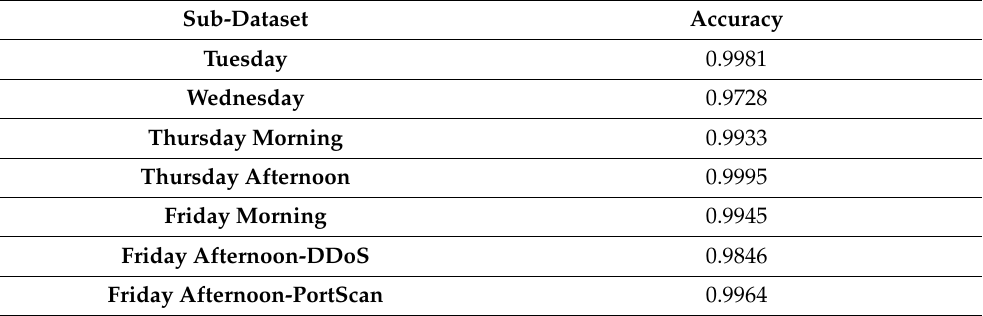
Figure 14. Friday afternoon PortScan confusion matrix. Table 11. Accuracy. Table 5. Statistical report of Wednesday test dataset.